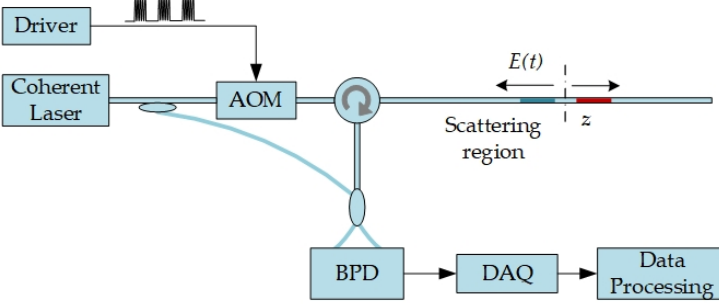
Figure 2. The system scheme of digital coherent detection. Reproduced from our previous paper [15].